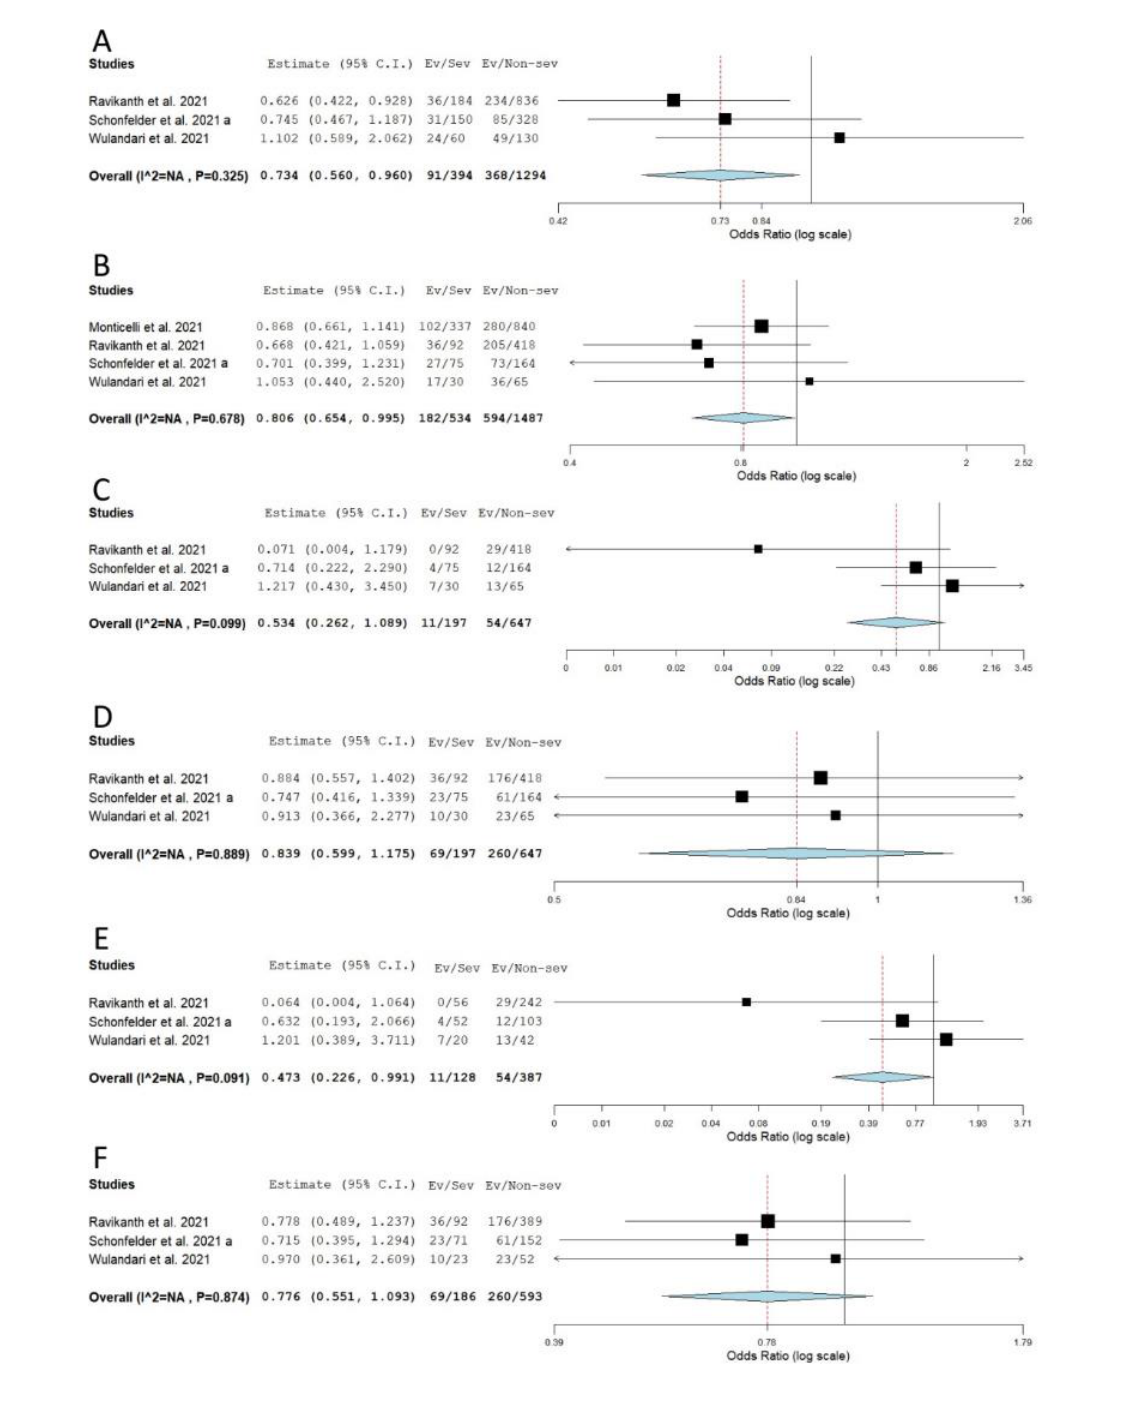
Figure 7: Meta-analysis of the association between rs12329760 in TMPRSS2 and COVID-19 severity: comparison severe vs. non-severe. A ) allelic model; B ) dominant model; C ) recessive model; D ) over- dominant model; E ) AA vs. GG; F ) GA vs. GG. The results of the included studies presented as ORs, with 95 % CI, and the overall effect with 95 % CI are shown in the forest plot. P values given are de- rived from heterogeneity